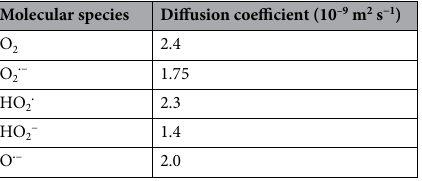
Table 1. Diffusion coefficients of the newly defined products from Frongillo et al. 31 .